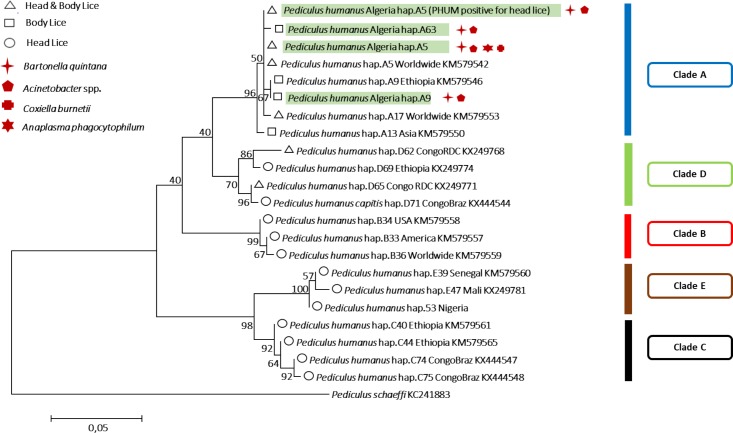
Phylogenetic tree showing the relationship of haplotypes identified in this study with other Pediculus humanus haplotypes.Phylogenetic inferences were conducted in MEGA 6 using the maximum likelihood method based on the Kimura 2-parameter. The GenBank accession numbers are indicated at the end. The mitochondrial clade memberships are indicated to the right of each tree. Specimens analyzed in this study are in green. A) Bacterial DNAs detected in body lice reported in this study. B) Lice samples positive for B. quintana, C. burnetii, A. phagocytophilum and Acinetobacter spp. and there are specified genotypes.